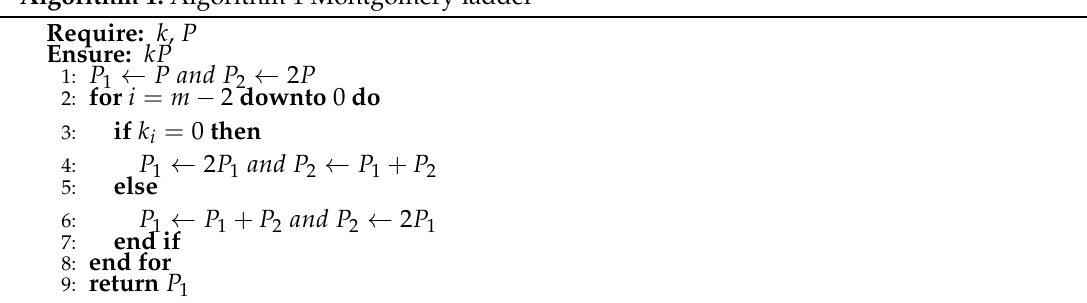
Algorithm 1: Algorithm 1 Montgomery ladder